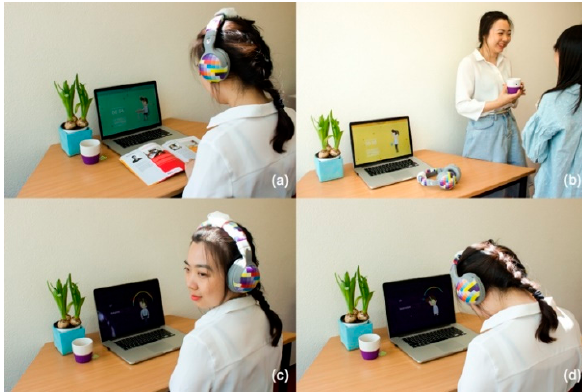
Figure 8. User interface ( a ) “Posture” page ( a ) and ( b ) “My Day”.